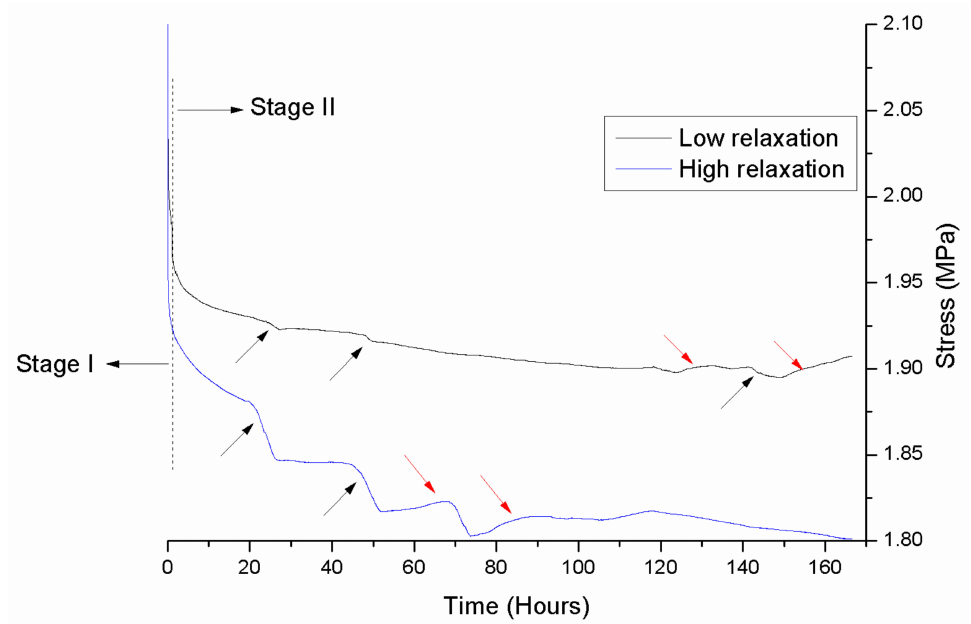
Figure 2. Representative stress–time curves from all materials tested over an observation time of 7 days. High and low relaxation curves were found for all materials. All curves are characterized by a first stage of an abrupt decrease of stress (Stage I), lasting approximately 2 hours, and a second stage (Stage II) with a low decrease of stress. Both curves demonstrate areas with sudden decrease of stress (black arrows) which in most cases are followed by a small increase of stress (red arrows).